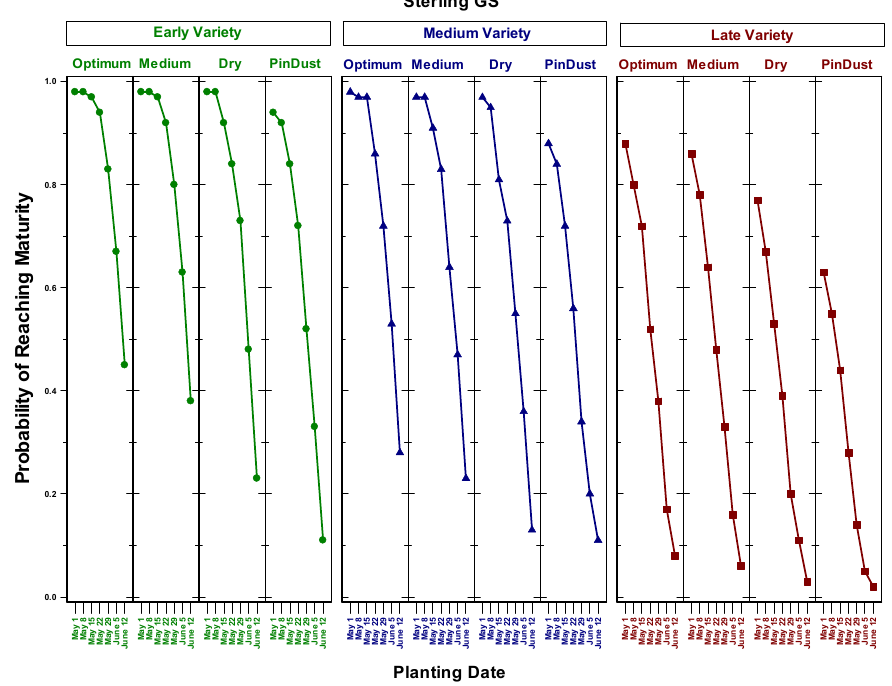
Figure 11. Probability of sorghum reaching physiological maturity at Sterling, Colorado for seven planting dates using non ‐ stressed (GS) phenological parameters, three maturity classes, and four seedbed water conditions at planting.